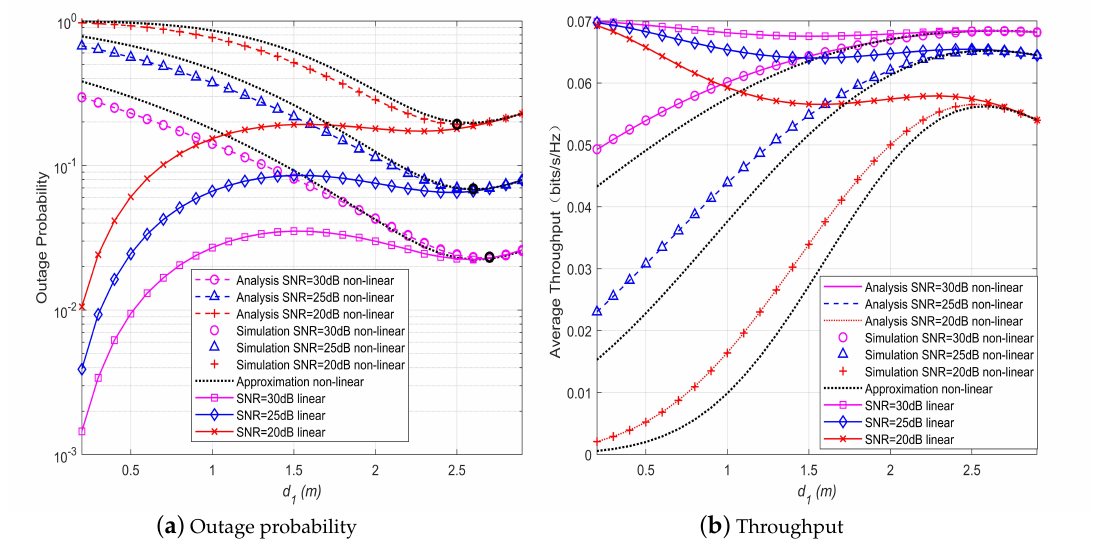
Figure 5. Performance comparison of different relay